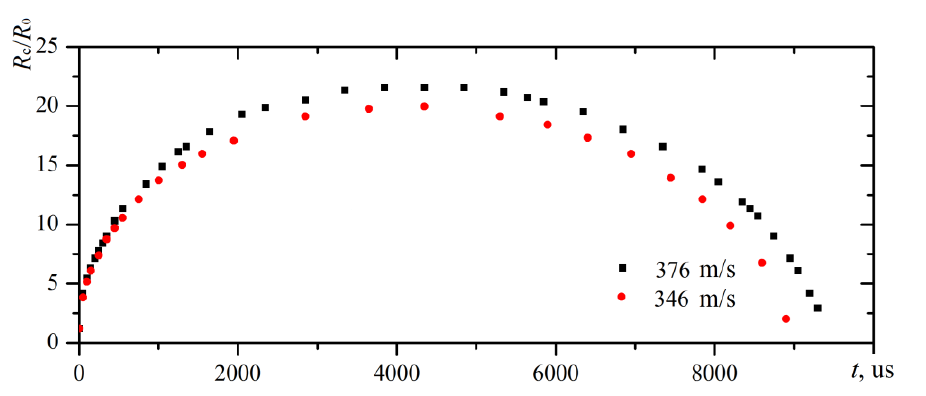
Fig. 4. Dependence of undisturbed cavity section radius on time for different body speeds (full